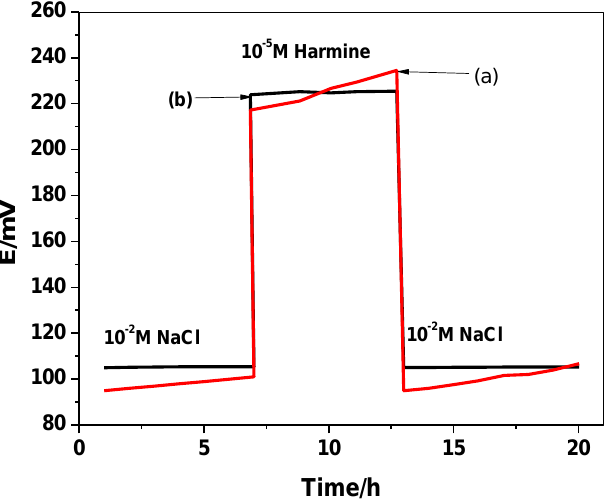
Figure 7. Water-layer test for ( a ) C/harmine-ISE and ( b ) C/PEDOT:PSS/harmine-ISE. Table 4. Harmine assessment in spiked urine specimens using C/PEDOT:PSS/harmine-ISE.